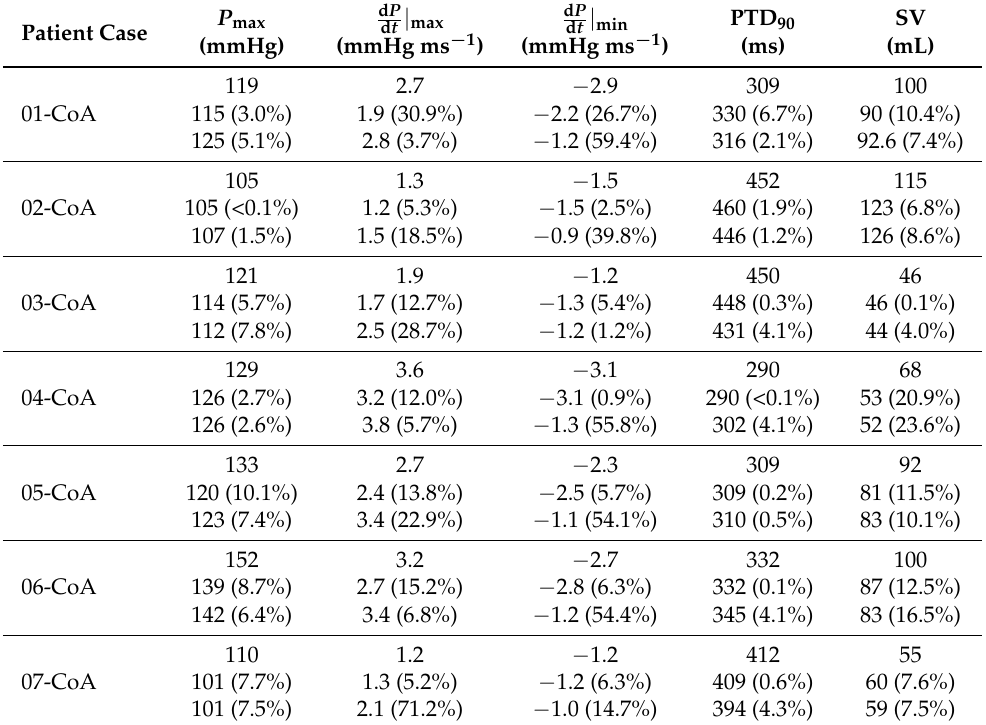
Table 2. Simulated and clinical LV pressure and volume biomarker values for each patient case. Clinical data are given in the first panel and results of the first and the second step of the active mechanics personalisation approach are given in the second and third panel. The goodness of fit is measured as relative difference between simulated and clinical value and given in